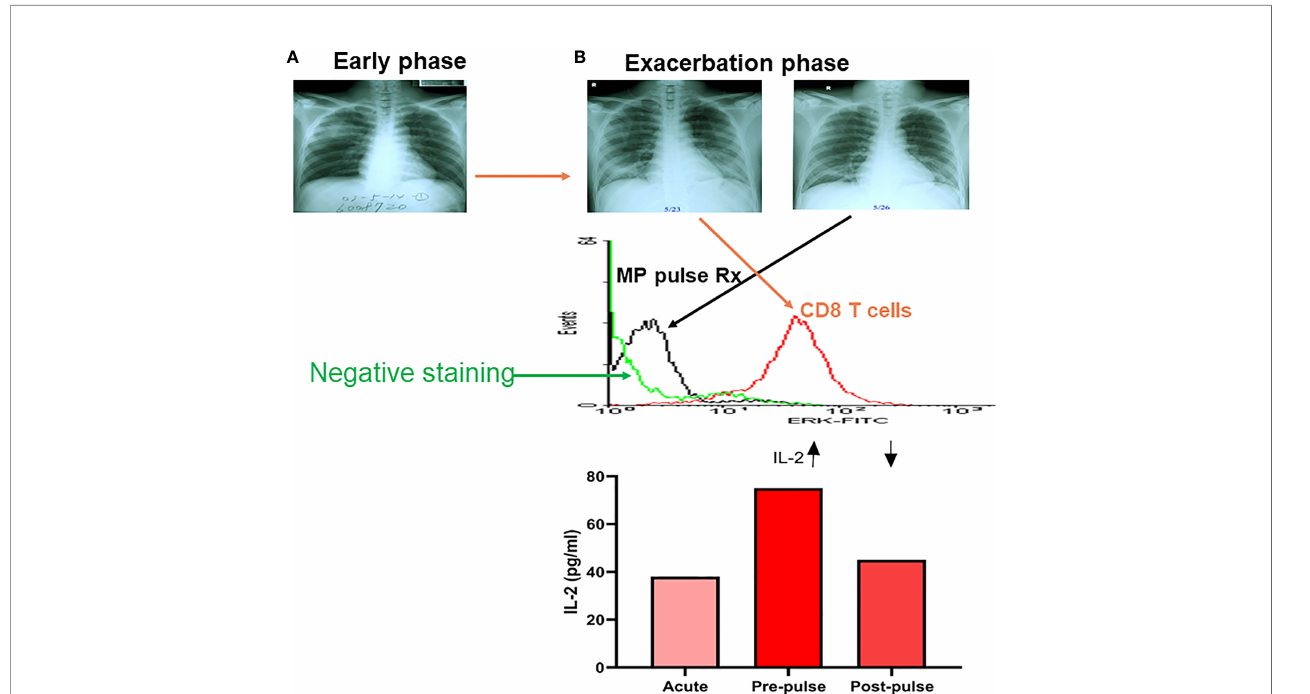
FIGURE 3 | A kinetic tracing of chest X-rays, intracellular p-ERK and plasma IL-2 levels in a patient with late exacerbation of SARS-CoV-1 before and after methylprednisolone pulse treatment (MP pulse Rx). An early phase X-rays fi lm in a SARS patient (A) , who developed late phase exacerbation (B) showing a high intracellular p-ERK level of CD8 T cells ( fl ow cytometric analysis of intracellular phosphorylated ERK levels) in exacerbation, and dramatically decreased after a 3-day course of methylprednisolone (MP; 1 gm/day) pulse Rx, associated with a decrease in plasma IL-2 level after the MP pulse Rx. (Data presented are derived from Li & Yang, et al. J Immunol. 2004;172